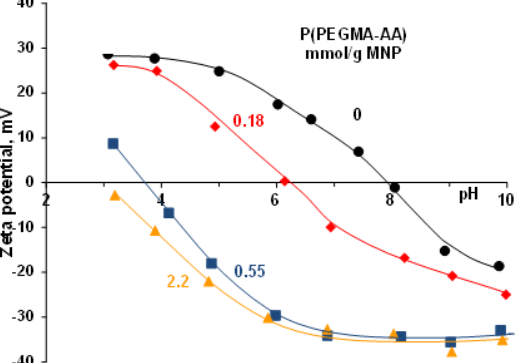
Figure 5. The pH-dependent zeta potentials of P(PEGMA-AA)-coated nanomagnets at 0, 0.18, 0.55, and 2.2 mmol COOH/g MNP loadings at 10 mM NaCl. The error bars are omitted for clarity and lines are drawn to guide the eyes.